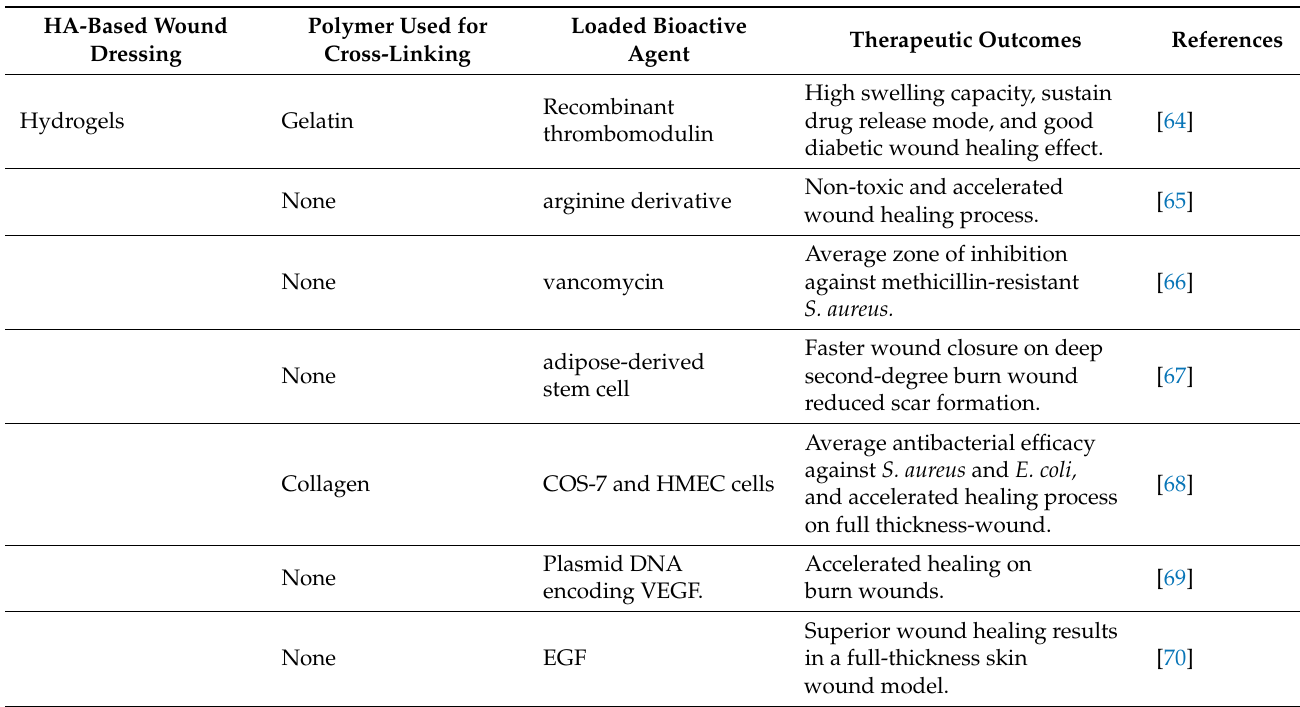
Table 3. HA-based Bioactive Wound